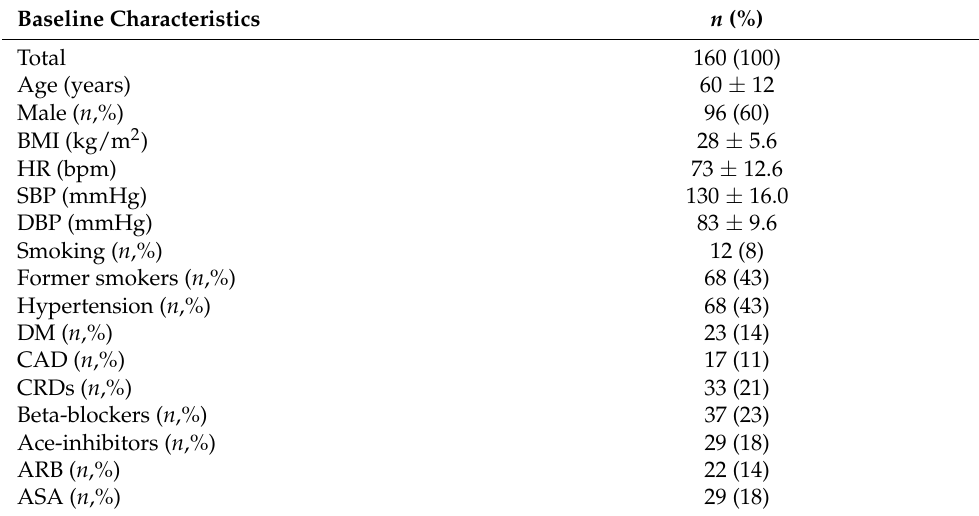
Table 1. Clinical data in the COVID-19 population ( n =